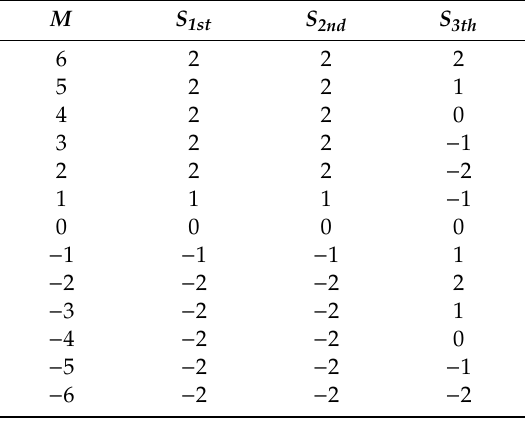
Table 1. Voltage level